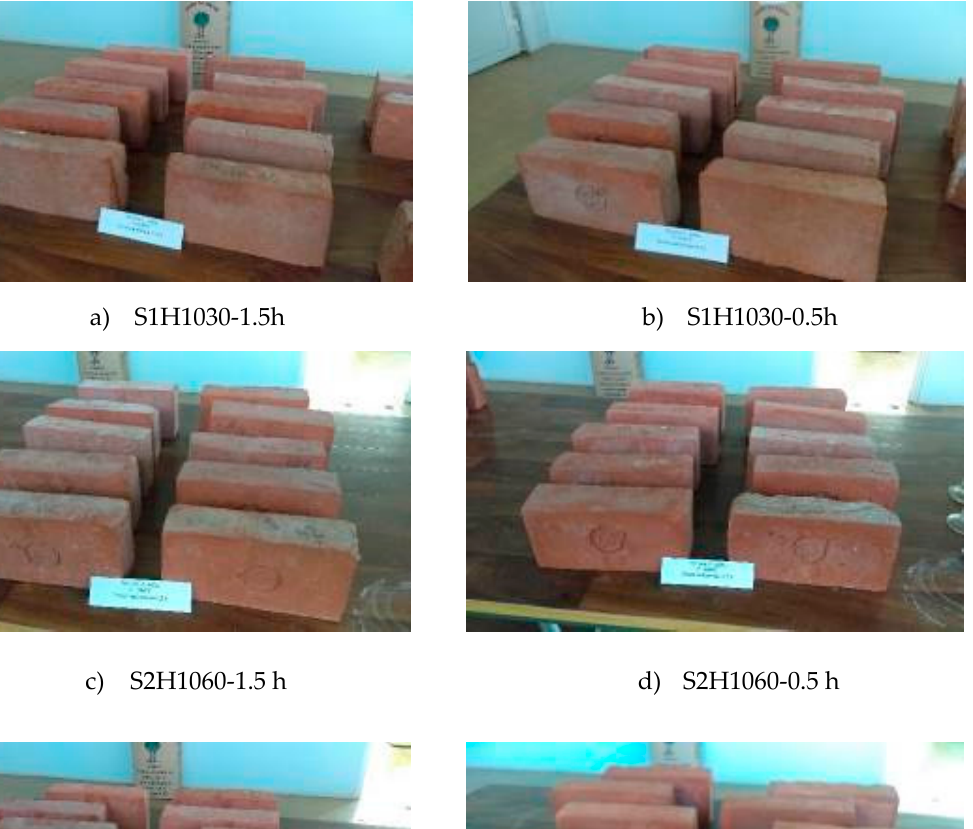
Figure 7. Pore-size distribution and total porosity of the ( a ) unfired bricks and ( b ) fired bricks. The appearance of the bricks after the exposure to freeze–thaw cycles are shown in Figure 8.